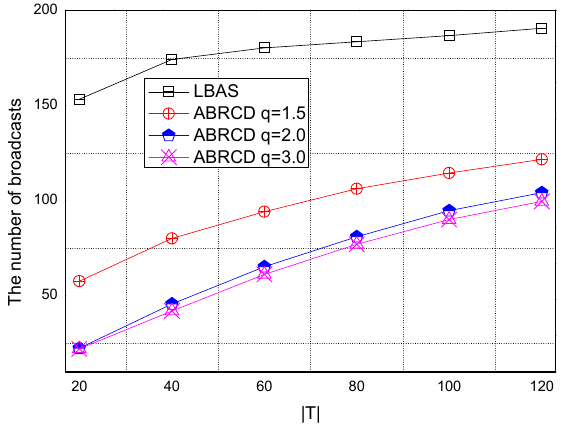
Figure 27. The impact of | T | and q with fixed network size = 200 on broadcasts. Sensors 2018 , 18 , x FOR PEER REVIEW